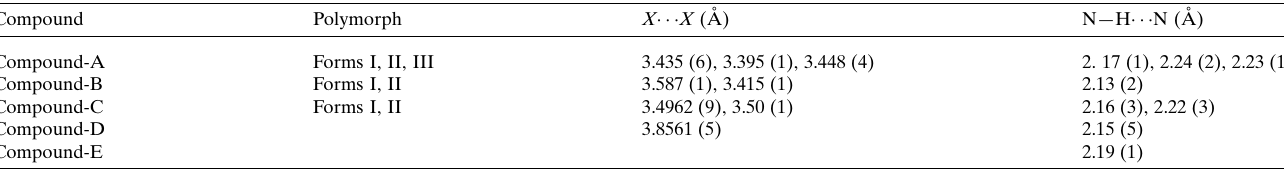
Table 1 Selected halogen- and hydrogen-bond distances in all nine polymorphic structures. Compound